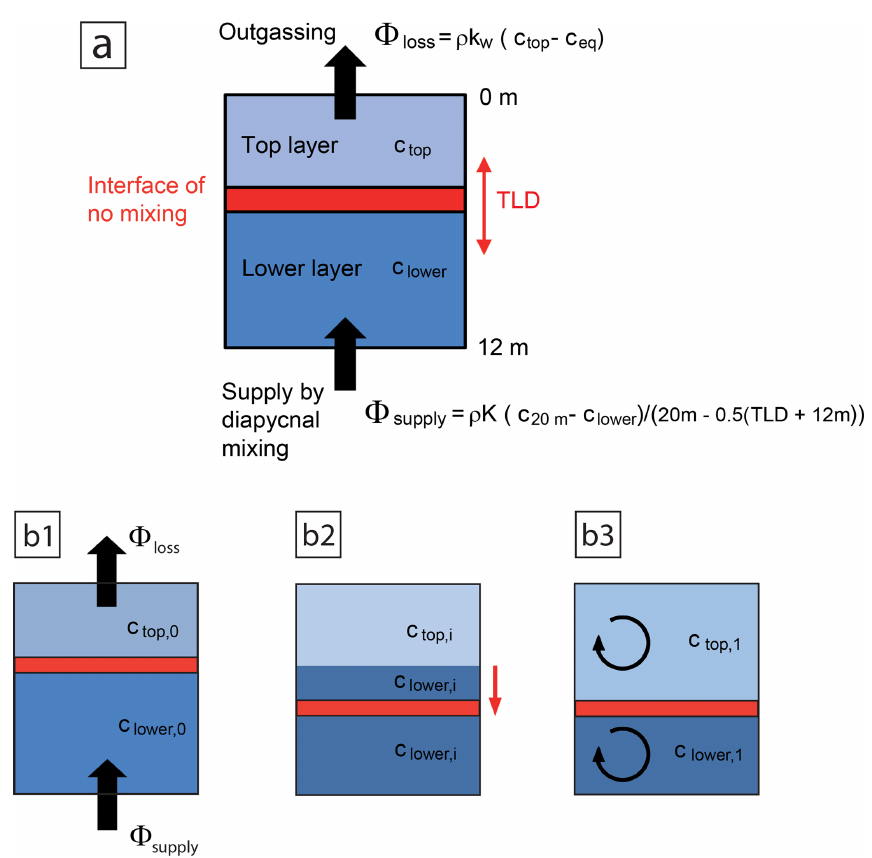
Figure 3. (a) The one-dimensional gas-transfer model to simulate the surface trapping mechanism. The interface of complete mixing in- hibition shifts up and down according to the high-resolution time series of observed TLD without instantaneously affecting local N 2 O concentrations. Vertical N 2 O transport is achieved by mixing within the two layers after the shifting interface has left a portion of c lower water in the top layer, or vice versa. Panels (b1–b3) demonstrate the processing sequence during a model time step. (b1) For the duration of the time step, supply flux and outgassing flux change c top and c lower , resulting in intermediate concentrations c top ,i and c lower ,i . (b2) After the time step, the TLD is shifted, in the example to a greater depth. (b3) Instantaneous linear mixing within the new top and lower layers results in concentrations c top , 1 and c lower , 1 , which serve as start values for the next model time